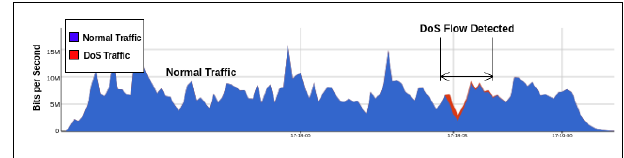
Figure 9. Protected UDP Flow